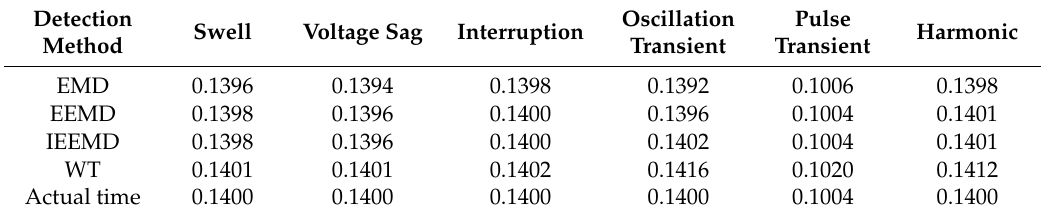
Table 3. The test results of the disturbances end time point.